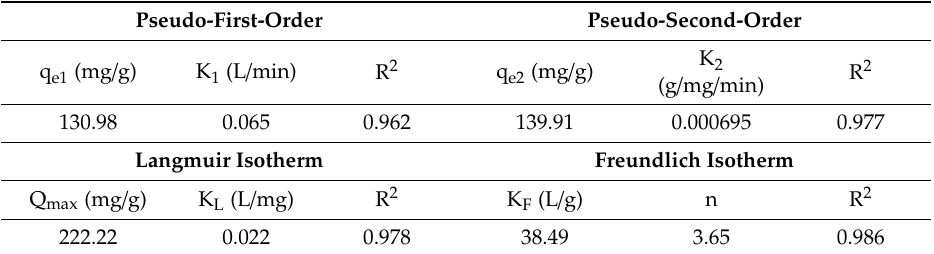
Table 1. Biosorption kinetic and adsorption isotherm parameters for the adsorption of Pb(II).